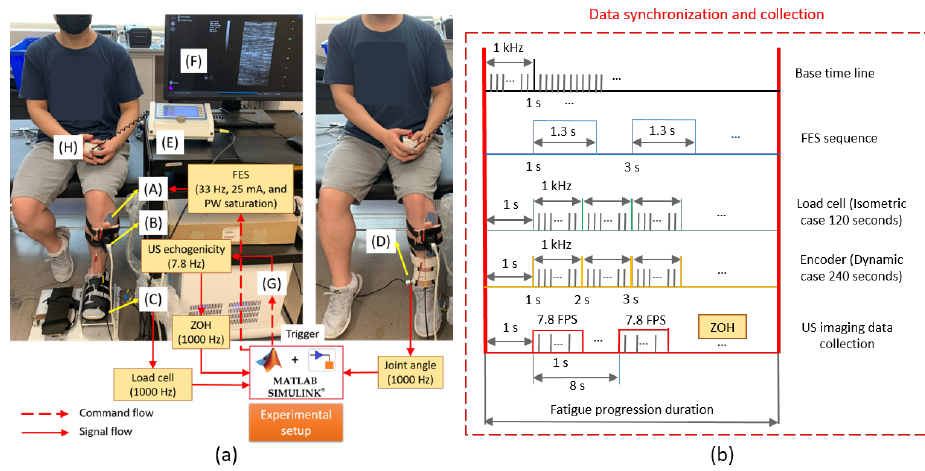
Figure 1. ( a ) Experimental setup of the isometric (left) and dynamic (right) ankle joint dorsiflexion by using FES. A—FES electrode pads, B—Prodigy US transducer, C—Load cell platform, D—Incremental encoder, E—FES stimulator, F—Monitor showing B-mode US imaging, G—Prodigy US machine, H—Safety stop button. ( b ) Data synchronization and collection among multiple